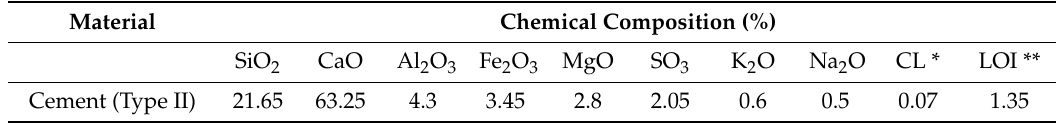
Table 1. Chemical composition of the